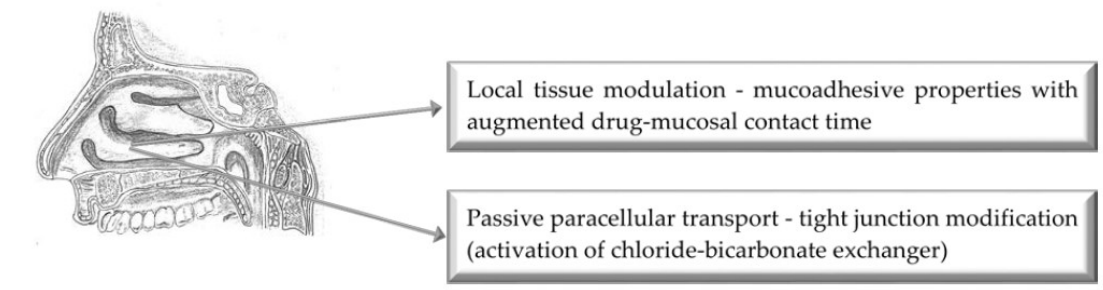
Figure 2. Illustration of the main mechanisms of action of bioenhancers for enhanced nasal drug delivery.